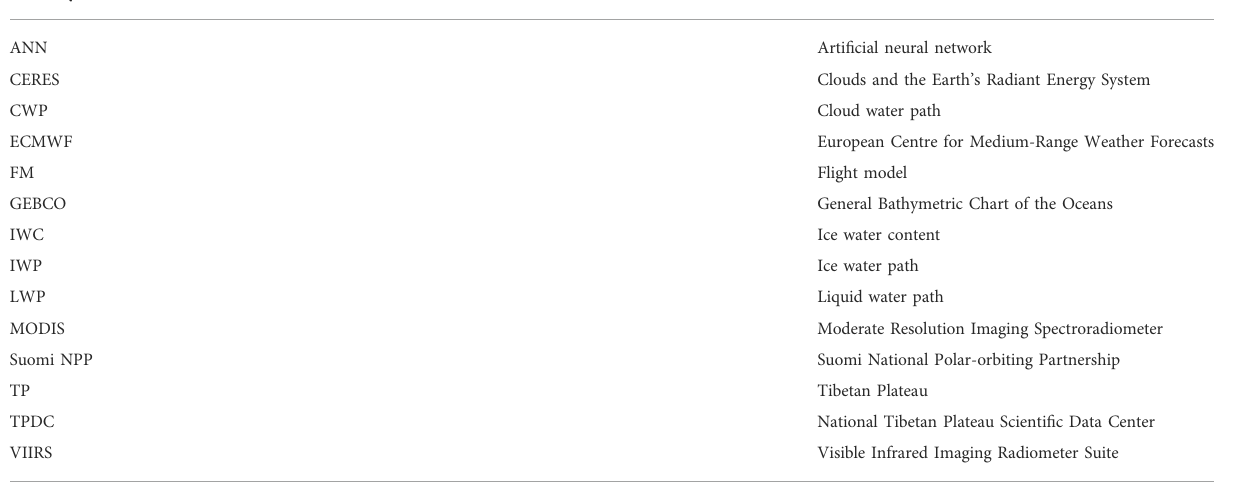
TABLE 1 Acronyms and abbreviations used in this study.